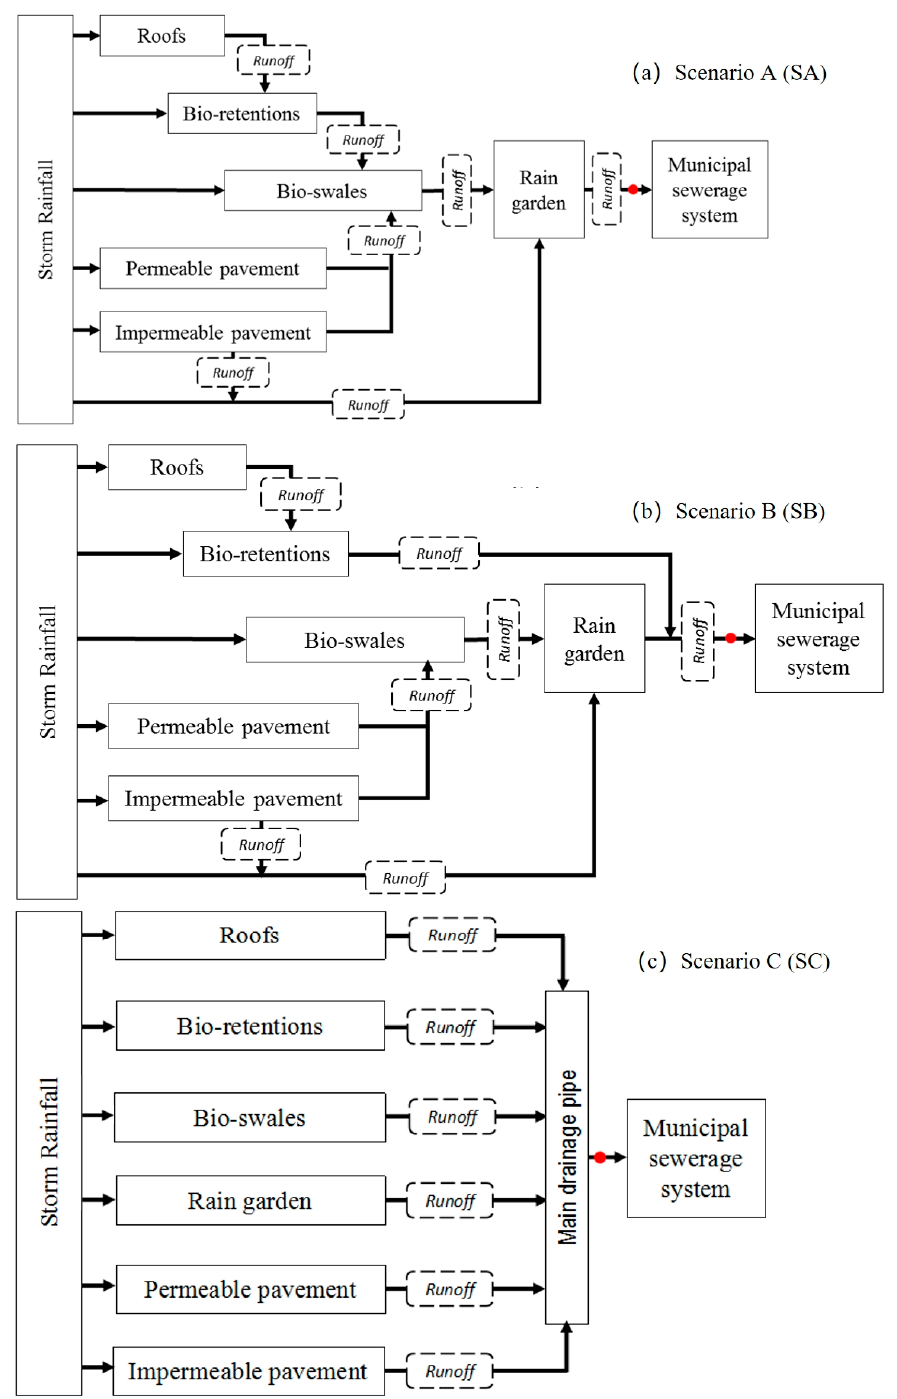
Figure 2. The schematic diagrams of the cascade-connected LID facilities ( a ); the semi-cascade- connected LID facilities ( b ); and the parallel-connected LID facilities ( c ). Additionally, the red dot is the runoff observation site.